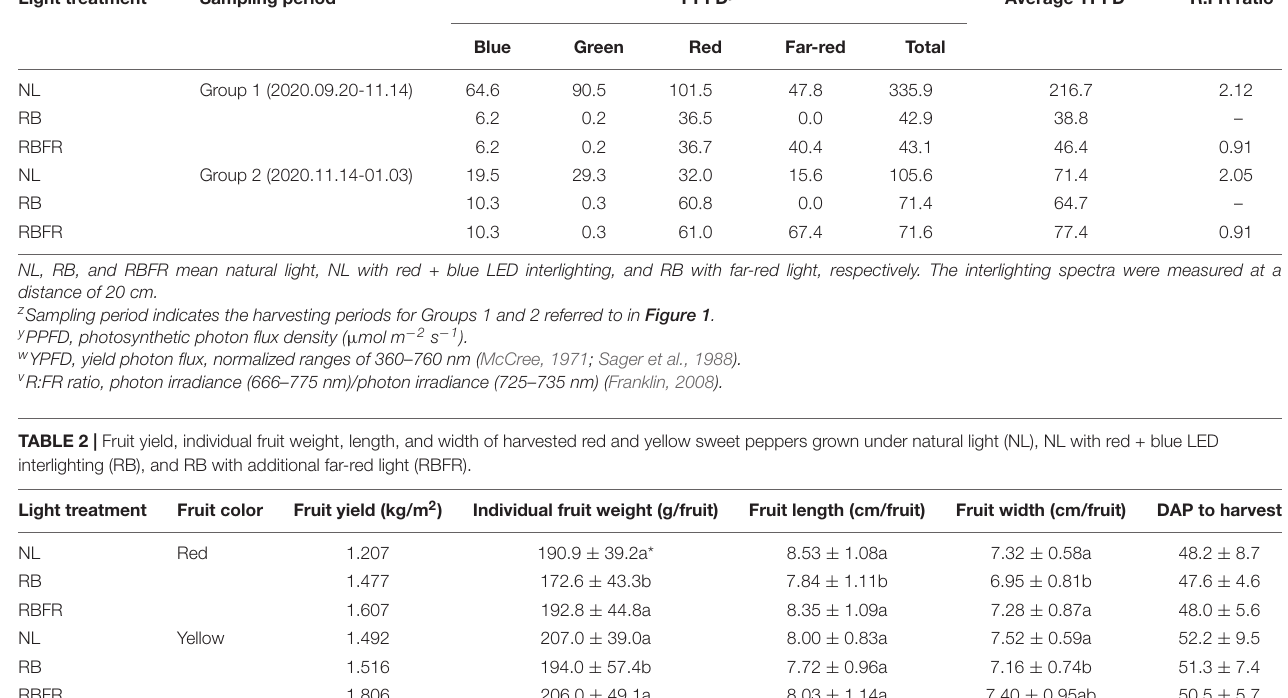
TABLE 1 | Spectral light intensities ( µ mol m − 2 s − 1 ) of the light treatments at different growth periods. Light treatment Sampling period z